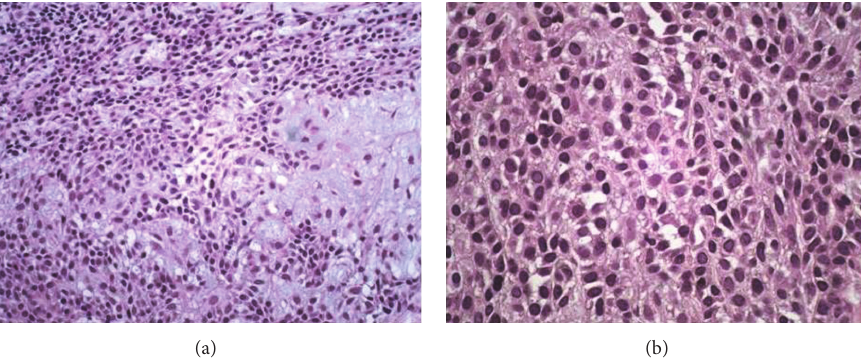
Figure 3: Microscopic view, H and E stain, 200x (a) and × 400 (b). Typical plasmacytoid myoepithelial cells among myxoid stroma.